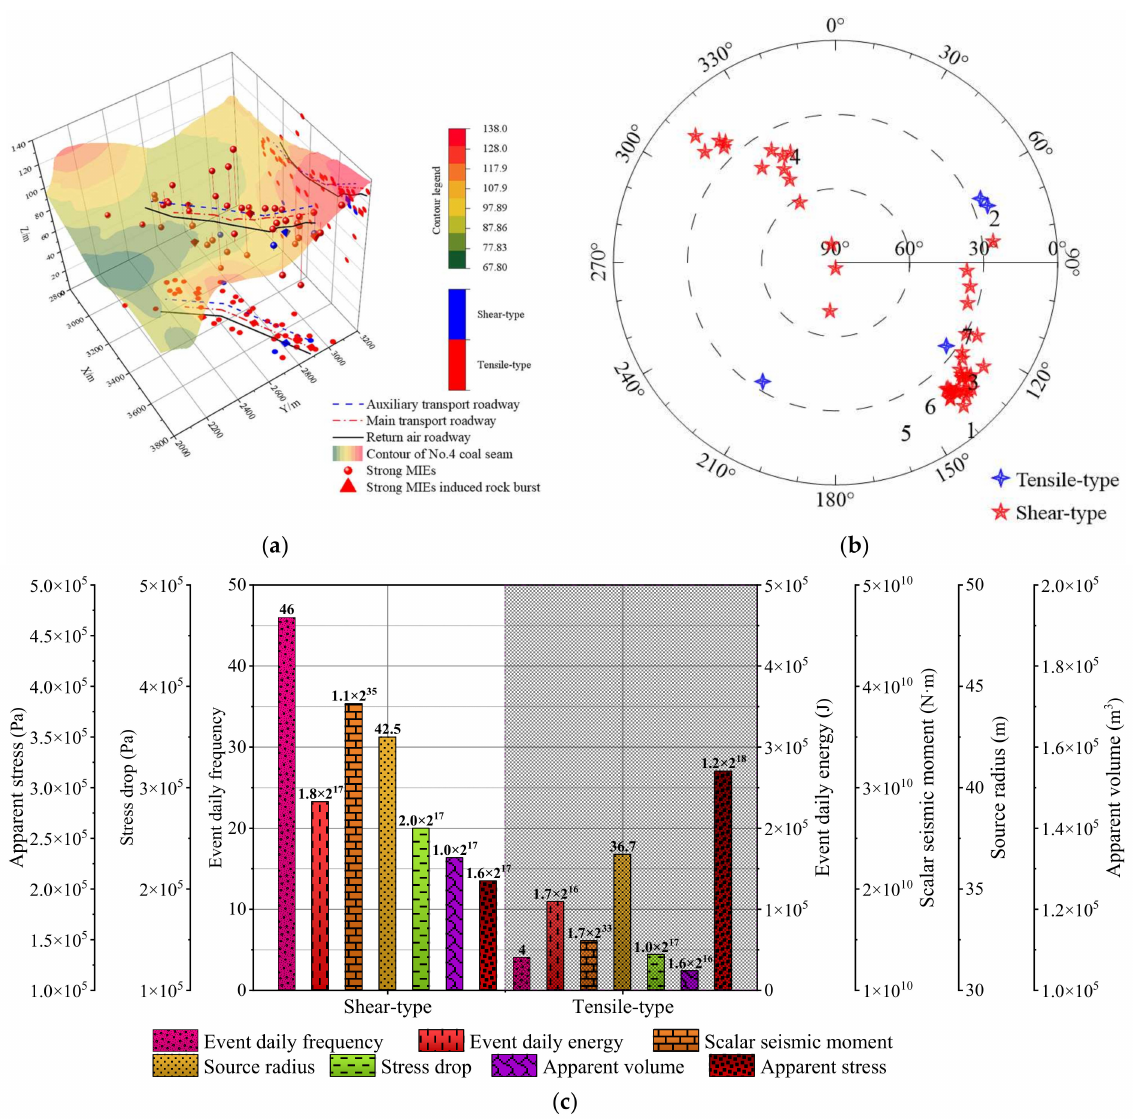
Figure 13. ( a ) Source location and focal mechanism solution of several strong MIEs in the roadway area of Gaojiapu Coal Mine. ( b ) Source rupture occurrence of strong MIEs. ( c ) Focal mechanism and response characteristics of focal parameters of strong